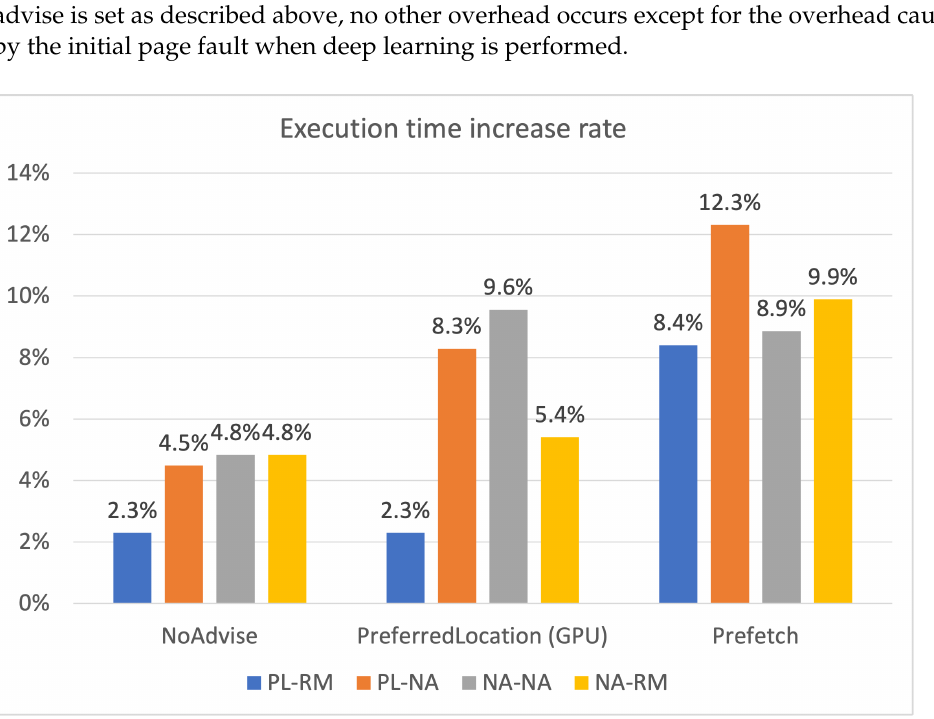
Figure 7. Training time increase rate due to the use of unified memory when the data size is smaller than the GPU memory